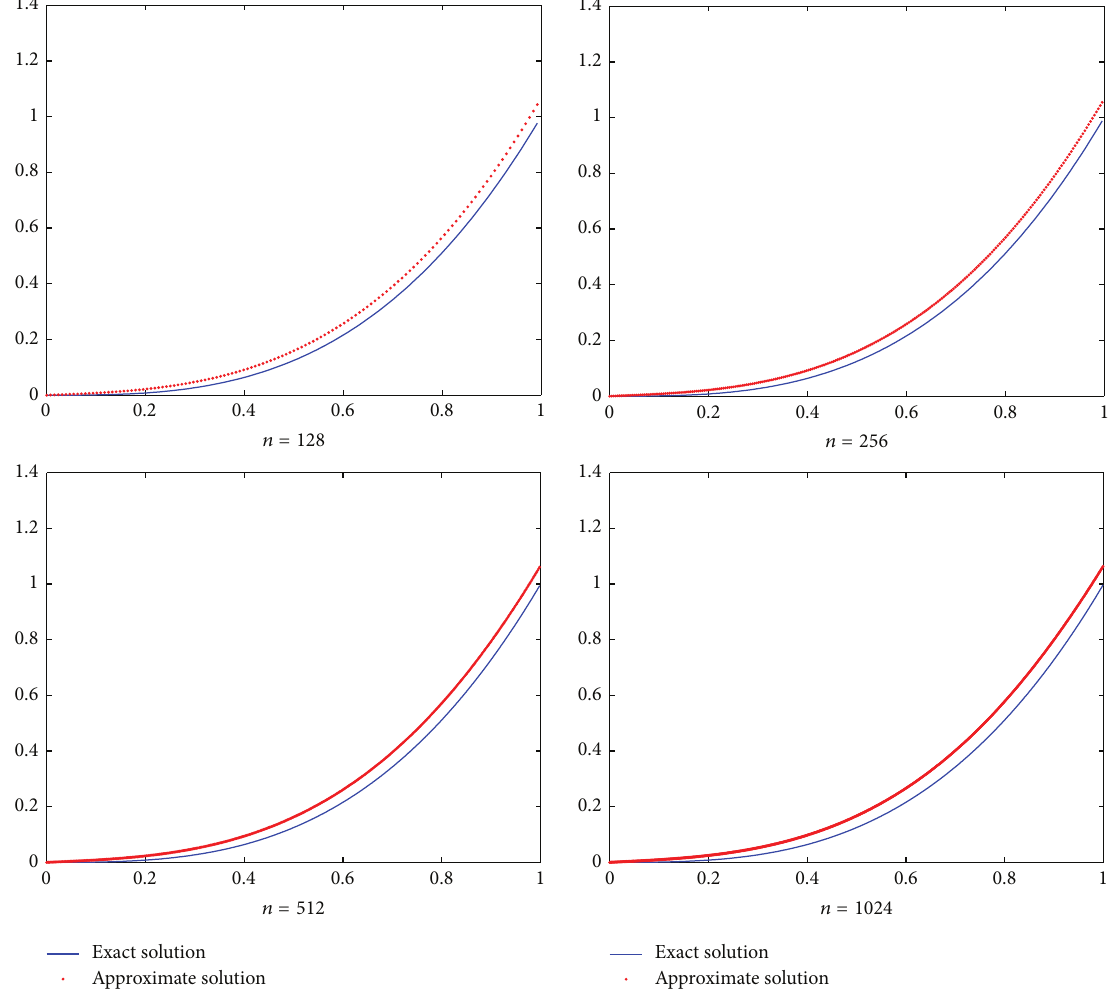
Figure 2: Curves of the exact and approximate solutions for 𝑛 = {128, 256, 512, 1024} . Table 1: Iterations and corresponding error estimates with 𝛿 = 1.8𝐸 − 5 , 𝜎 = 1